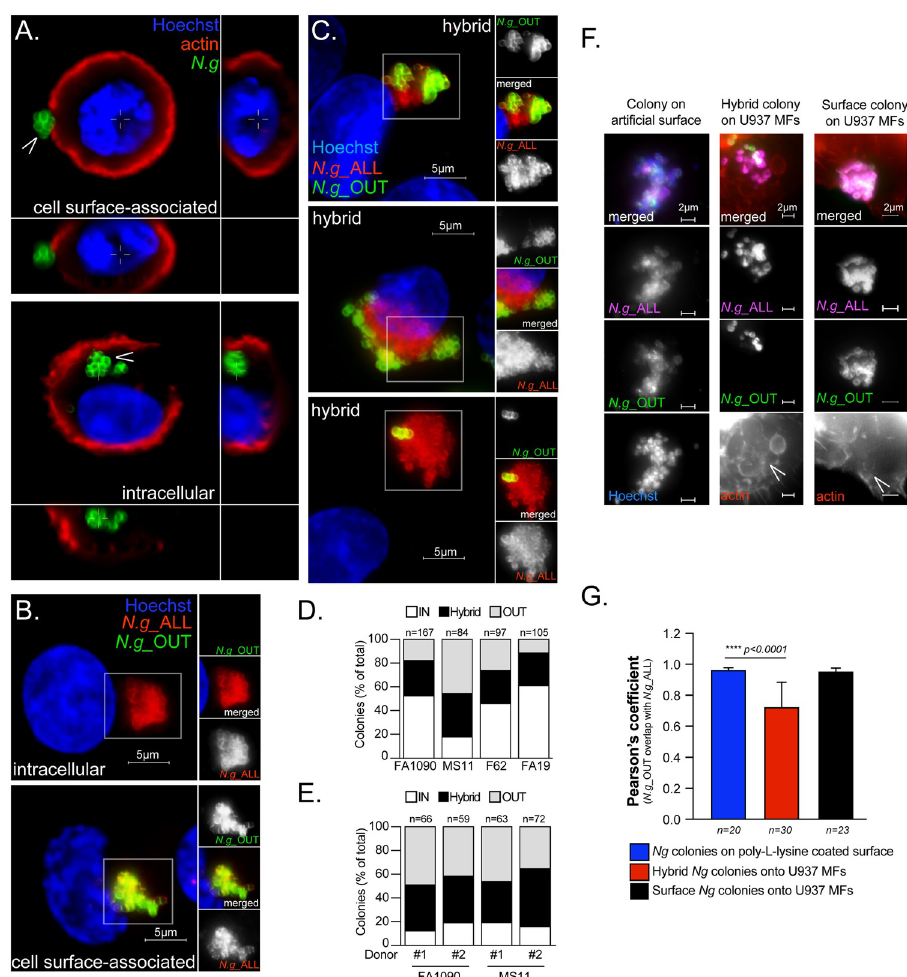
Fig 3. Gonococci colonize distinct cellular compartments. (A-C) U937 MFs infections with N . g FA1090 at MOI = 2. (A) Representative single focal plane of 3D image Z-stacks showing intracellular and cell-surface associated gonococcal colonies at 6 hpi. Side panels show Z-axis reconstruction at the indicated cross-sections. (B-C) Micrographs of colonized macrophages after inside/out staining with anti- N . g antibodies. (B) Single-stained intracellular (red) and double-stained surface-exposed (yellow) gonococcal colonies are shown. (C) Multiple representative partially exposed (hybrid) gonococcal colonies (yellow and red) are shown. (D-E) Quantitative analyses of the relative colony topologies distributions from infections with different N.g strains at 10hpi (D) in U937 MFs and (E) in human primary monocyte-derived macrophages (hMDMs) derived from two distinct donors are shown. (F) Representative z- projections micrographs of N . g colonies formed on artificial surface (poly-L-lysine coated glass coverslips) or in association with U937 MFs that were stained using the inside/out methodology. (G) Analysis of N . g _OUT and N . g _ALL signal colocalization using Pearson’s correlation coefficient (PCC) in each of the three N . g colony types represented in (F) . Means ± SD are shown, unpaired T-test analysis. (A-G) Representative experiments from two (E-G) or at least three (A-D) biological replicates are included. (D-E, G) The number of colonies analyzed from each condition is indicated by “ n ”.